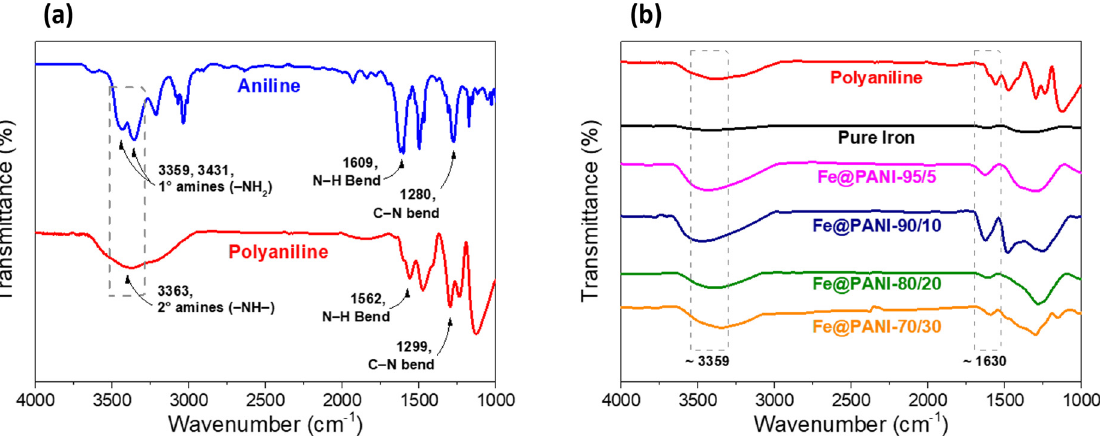
Figure 7. FTIR analysis ( a ) before (aniline) and after (polyaniline) polymerization, ( b ) series of Fe@PANI nanowires with 0 − 30 wt.% PANI additions.